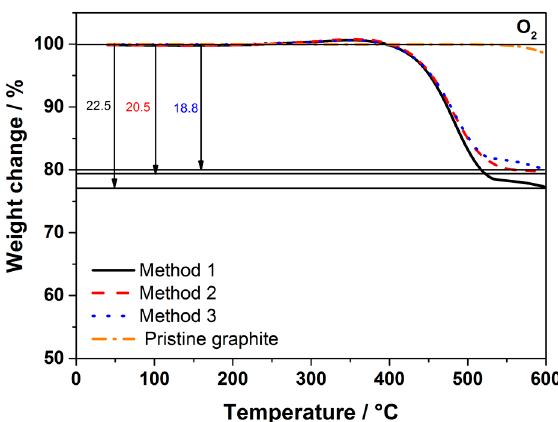
Figure 1. Thermogravimetric analysis (TGA) traces in oxygen atmosphere of pristine and carbon-coated graphite. Sucrose was used as the carbon precursor for all synthesis routes.